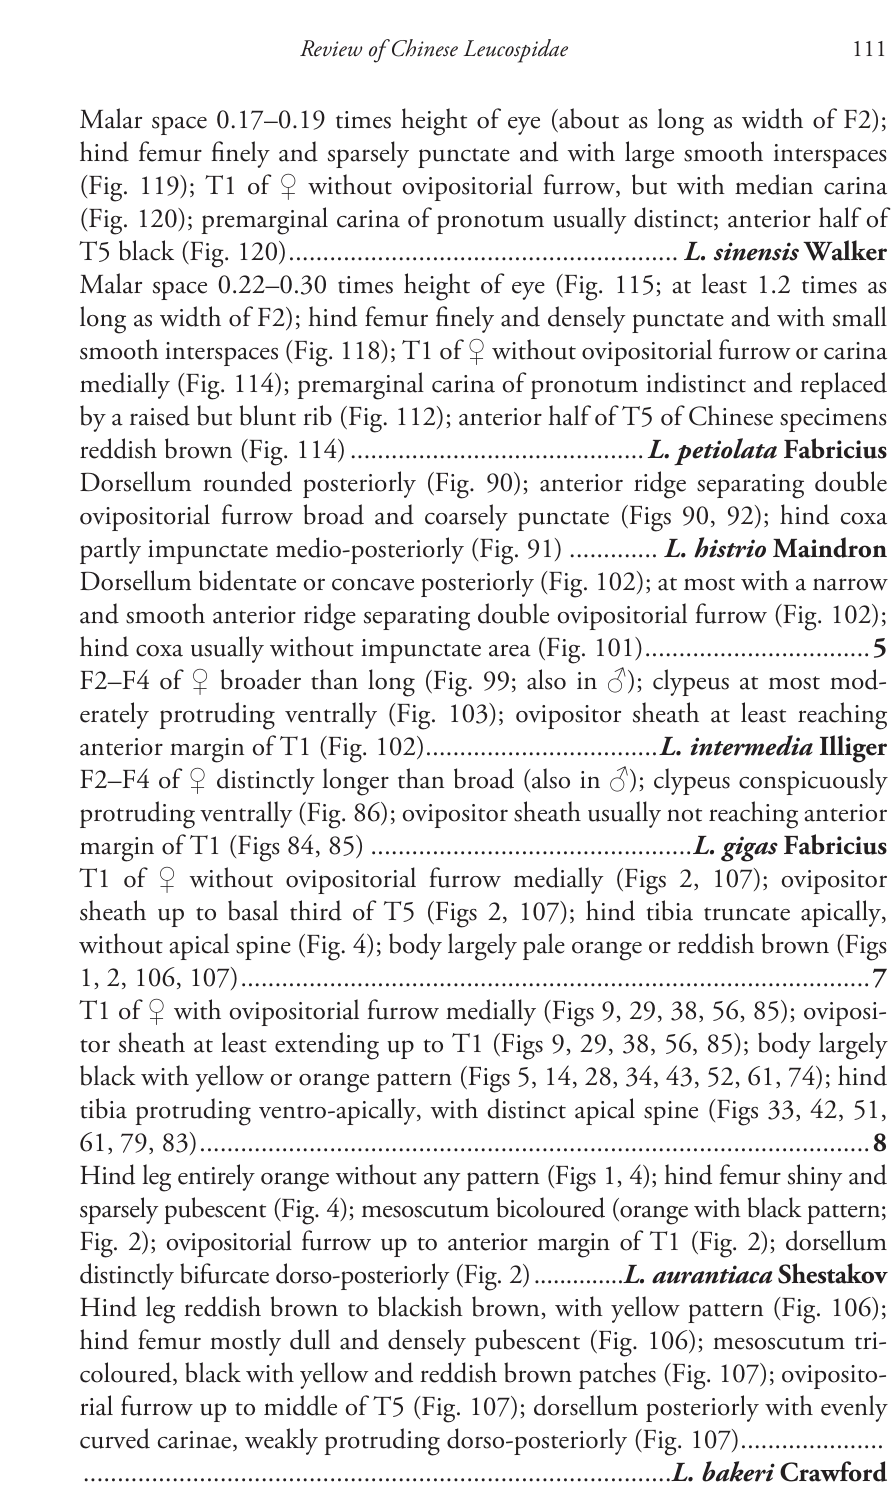
Malar space 0.17–0.19 times height of eye (about as long as width of F2); hind femur finely and sparsely punctate and with large smooth interspaces (Fig. 119); T1 of ♀ without ovipositorial furrow, but with median carina (Fig. 120); premarginal carina of pronotum usually distinct; anterior half of T5 black (Fig. 120) ......................................................... L. sinensis Walker – Malar space 0.22–0.30 times height of eye (Fig. 115; at least 1.2 times as long as width of F2); hind femur finely and densely punctate and with small smooth interspaces (Fig. 118); T1 of ♀ without ovipositorial furrow or carina medially (Fig. 114); premarginal carina of pronotum indistinct and replaced by a raised but blunt rib (Fig. 112); anterior half of T5 of Chinese specimens reddish brown (Fig. 114) ........................................... L. petiolata Fabricius 4 Dorsellum rounded posteriorly (Fig. 90); anterior ridge separating double ovipositorial furrow broad and coarsely punctate (Figs 90, 92); hind coxa partly impunctate medio-posteriorly (Fig. 91) ............. L. histrio Maindron – Dorsellum bidentate or concave posteriorly (Fig. 102); at most with a narrow and smooth anterior ridge separating double ovipositorial furrow (Fig. 102); hind coxa usually without impunctate area (Fig. 101) ................................. 5 5 F2–F4 of ♀ broader than long (Fig. 99; also in ♂ ); clypeus at most mod- erately protruding ventrally (Fig. 103); ovipositor sheath at least reaching anterior margin of T1 (Fig. 102) .................................. L. intermedia Illiger – F2–F4 of ♀ distinctly longer than broad (also in ♂ ); clypeus conspicuously protruding ventrally (Fig. 86); ovipositor sheath usually not reaching anterior margin of T1 (Figs 84, 85) ............................................... L. gigas Fabricius 6 T1 of ♀ without ovipositorial furrow medially (Figs 2, 107); ovipositor sheath up to basal third of T5 (Figs 2, 107); hind tibia truncate apically, without apical spine (Fig. 4); body largely pale orange or reddish brown (Figs 1, 2, 106, 107) ............................................................................................ 7 – T1 of ♀ with ovipositorial furrow medially (Figs 9, 29, 38, 56, 85); oviposi- tor sheath at least extending up to T1 (Figs 9, 29, 38, 56, 85); body largely black with yellow or orange pattern (Figs 5, 14, 28, 34, 43, 52, 61, 74); hind tibia protruding ventro-apically, with distinct apical spine (Figs 33, 42, 51, 61, 79, 83) .................................................................................................. 8 7 Hind leg entirely orange without any pattern (Figs 1, 4); hind femur shiny and sparsely pubescent (Fig. 4); mesoscutum bicoloured (orange with black pattern; Fig. 2); ovipositorial furrow up to anterior margin of T1 (Fig. 2); dorsellum distinctly bifurcate dorso-posteriorly (Fig. 2) .............. L. aurantiaca Shestakov – Hind leg reddish brown to blackish brown, with yellow pattern (Fig. 106); hind femur mostly dull and densely pubescent (Fig. 106); mesoscutum tri- coloured, black with yellow and reddish brown patches (Fig. 107); oviposito- rial furrow up to middle of T5 (Fig. 107); dorsellum posteriorly with evenly curved carinae, weakly protruding dorso-posteriorly (Fig. 107) ..................... ...................................................................................... L. bakeri